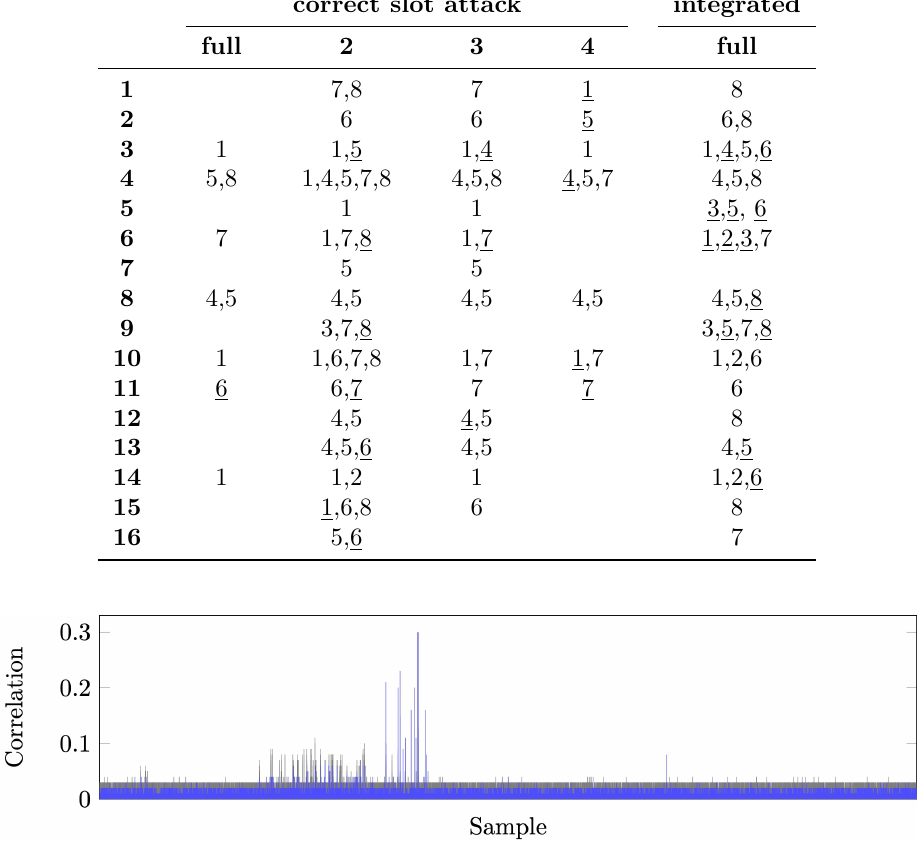
Table 3: Which bit is vulnerable to each of 16 bytes either in a correct slot attack (by 767 plaintexts) or in an integrated attack (by 15 thousand plaintexts) with a full set of multipliers or a subset of multipliers with cardinality 2 or 3 or 4 . The underlined bit means the good key guess ranked first in the correlation score, but the advantage is not significantly high. The blank cell means no bit was vulnerable in the corresponding attack.